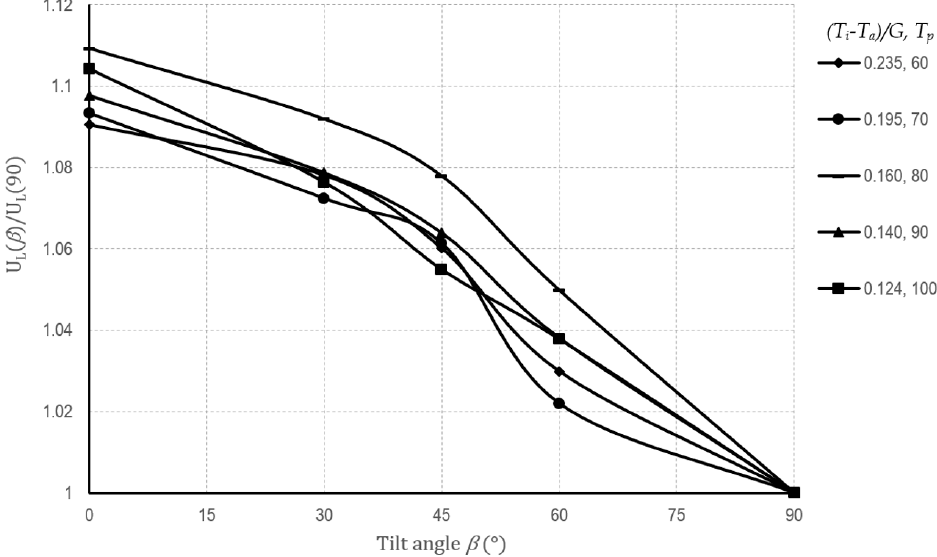
Figure 6. U L ( β )/ U L (90°) vs. β and ( T i − T a )/ G , at ( T o − T i ) = 0.